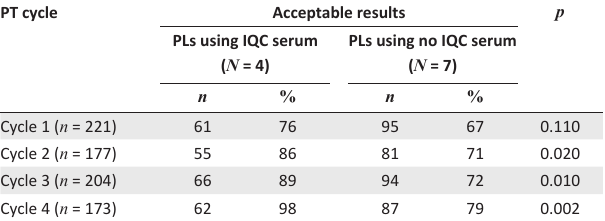
TABLE 4: Comparison of participating laboratories’ performance based on the use of internal quality control in Togo from July 2016 to December 2016. PT cycle